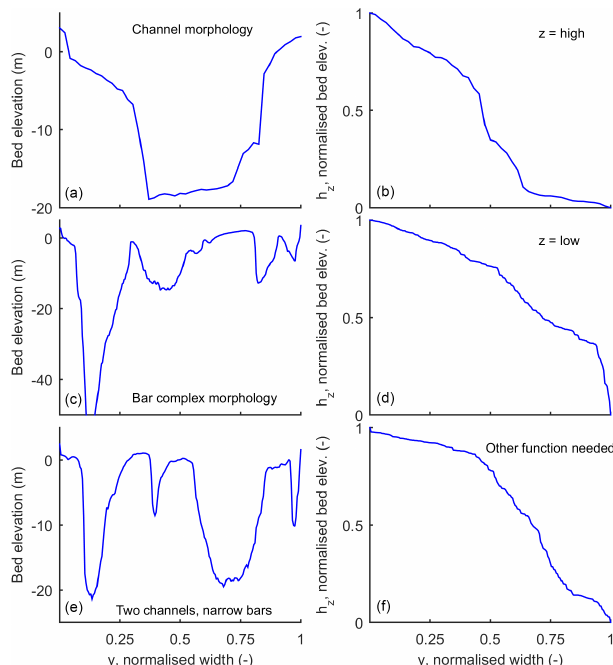
Figure 3. Example cross sections and hypsometry, suggesting that channel-dominated morphology (a, b) generally results in concave hypsometric functions (high z value in Fig. 2), while bar complexes (c, d) generally result in convex hypsometry (low z value in Fig. 2). In the case of narrow bars with a flat top and relatively steep tran- sition from bar top to channel, the original hypsometry function by Strahler (1952) is less appropriate and the inverted function fits bet-